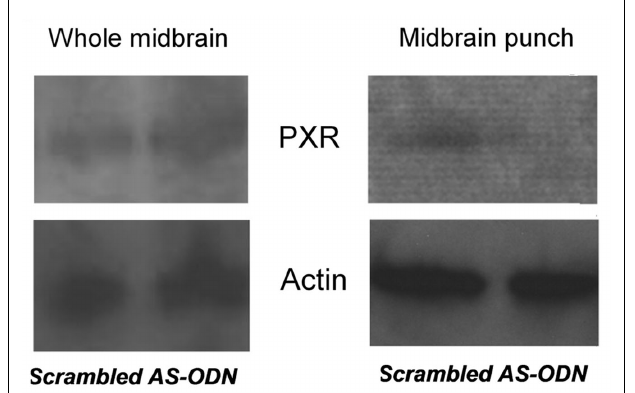
FIGURE 6 |Western blots of pregnane xenobiotic receptor (PXR) expression (top) and β -actin control (bottom) in the whole midbrain (left) and punchVTA infusion site (right) of rats administered scrambled control or PXR antisense oligodeoxynucleotides (ODNs).